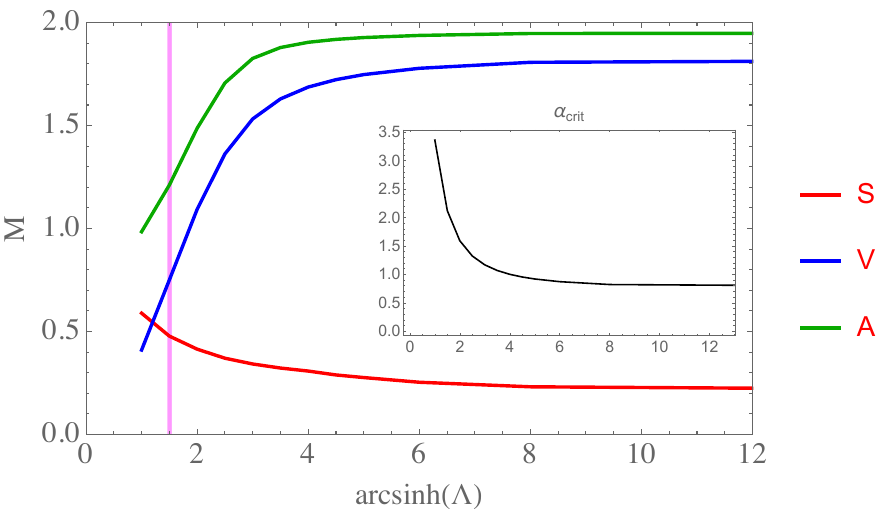
Figure 6 . Masses at the critical point as a function of the UV cuto(cid:11) (cid:3) with m tot = 1. Insert shows (cid:11) crit ((cid:3)).